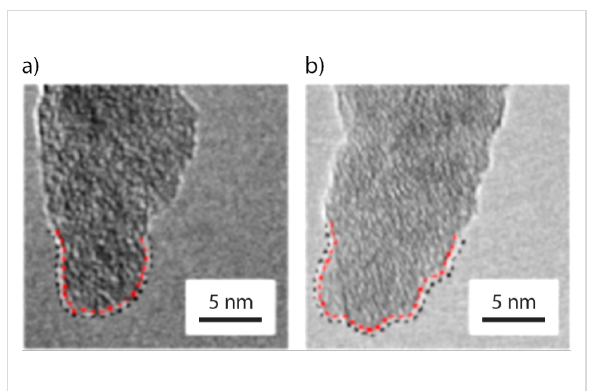
Figure 2: (a) TEM image of the AFM tip apex before AFM imaging. (b) TEM image of the AFM tip apex after AFM imaging. No appre-